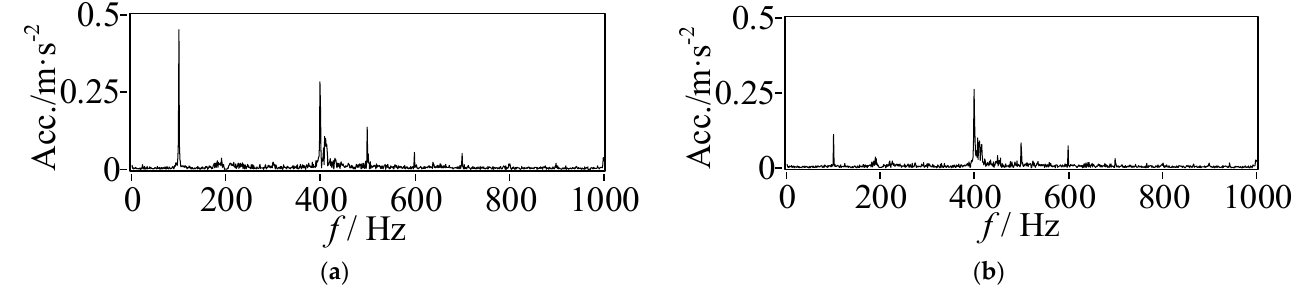
Figure 13. Base acceleration spectrum before and after rotor LMS compensation. ( a ) Compensation for acceleration spectrum of the front base; ( b ) Acceleration spectrum of the base after compensation.